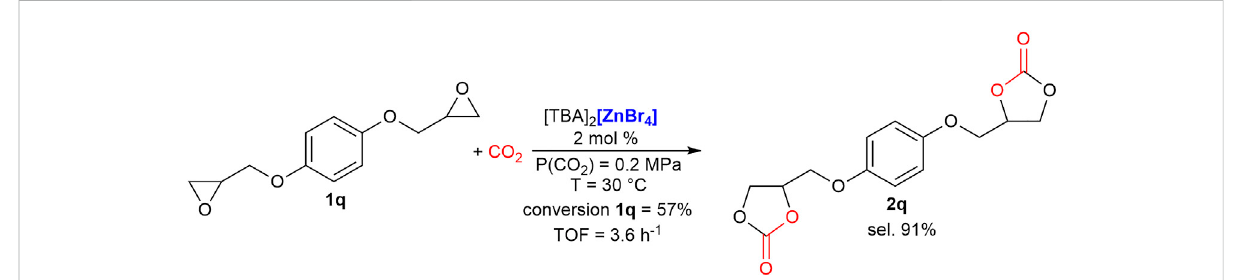
SCHEME 3 Selective synthesis of bis -carbonate of 1,4- bis (benzyloxy)diglycidyl ether, 2q. Reaction conditions: epoxide, 1q , (222 mg, 1 mmol) dissolved in CH 3 CN (0.5 ml); cat. 2 mol%. Conversion and selectivity determined by 1 H NMR using mesitylene as the internal standard. Turnover frequency